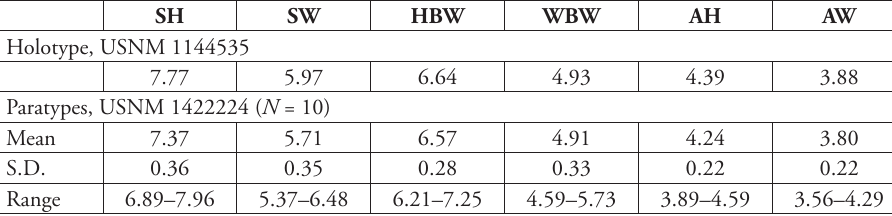
Table 2. Shell parameters for F. umpquaensis . Measurements are in